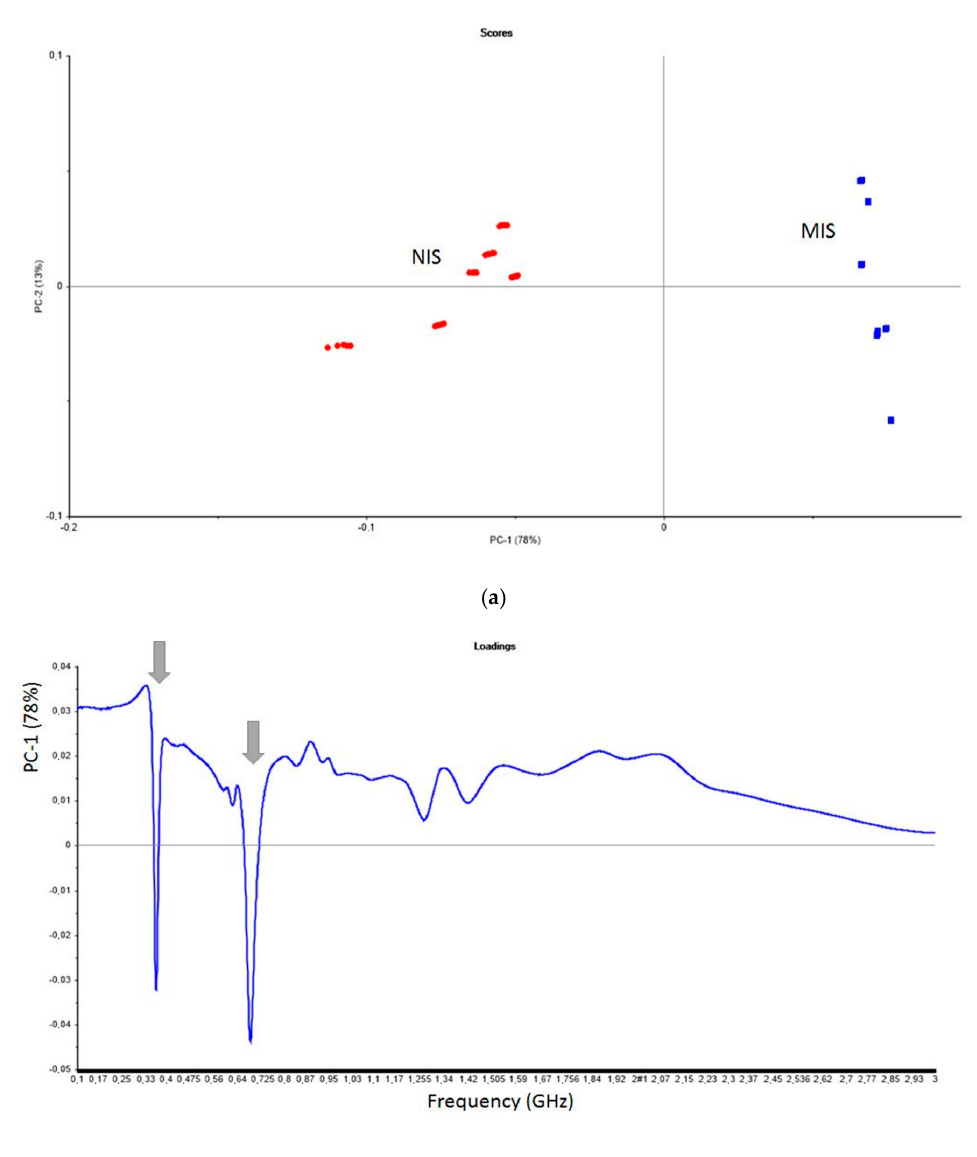
Figure 3. ( a ) PCA model of data presented in the two-dimensional space for the two principal components PC1 and PC2 explaining 91% of the total variance in the data. Example of procymidone detection in model wine medium (water/ethanol, 90/10, v / v ) using the microwave sensor coupled to MIS or NIS. 29 samples from the MIS sensor and 30 samples from the NIS sensor. The procymidone concentration varied from 5 to 250 ng L − 1 . ( b ) Detection of procymidone in model wine medium (water/ethanol, 90/10, v / v ) using the microwave sensor coupled to MIS or NIS. Loading plot for the first principal component (PC1).